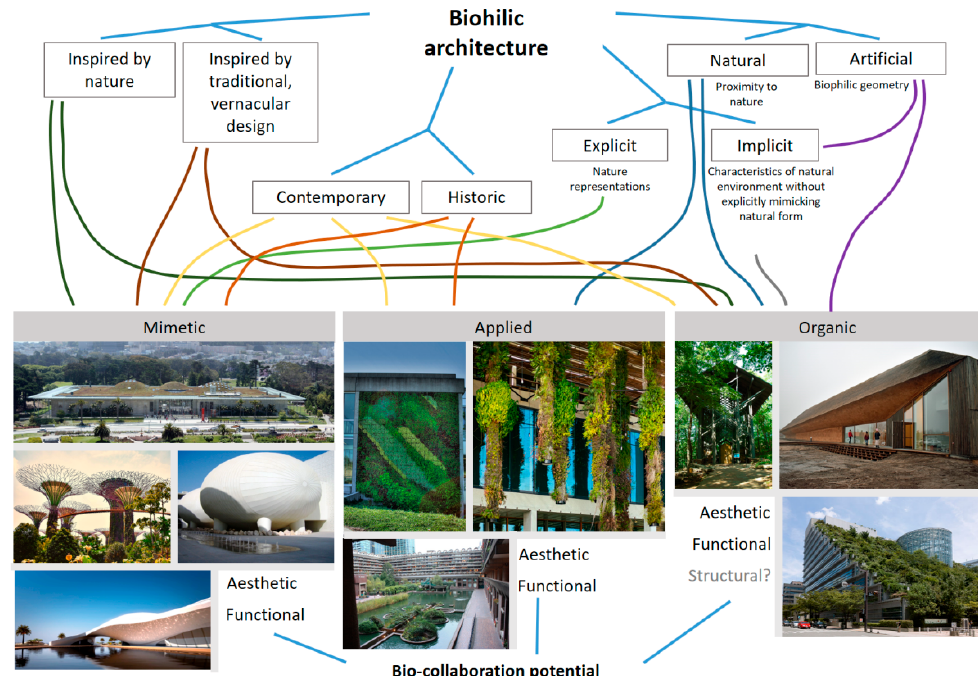
Figure 1. Existing classifications of biophilic architecture distinguished after a literature analysis and their links with proposed biophilic architecture categories: mimetic, applied, and organic. Each of three categories is illustrated by characteristic examples. Mimetic biophilic design: California Academy of Sciences (USA), Supertree Grove (Singapore), Weill Cornell Medical College (Qatar), BEEAH Headquarters (UAE). Applied biophilic design: green wall at Simon Fraser University (Canada), Perez Museum (Miami, Florida, USA), Khoo Teck Puat Hospital (Singapore), Barbican Estate (London, UK). Organic biophilic design: Thorncrown Chapel (USA), Wadden Sea Centre (Denmark), Acros building (Japan). All the images used in the illustration are from Wikimedia commons.